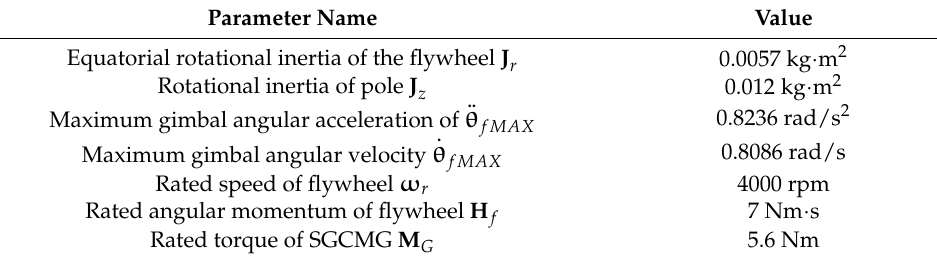
Figure 8. Experimental setup. ( a ) SGCMG prototype, ( b ) Octagonal cone−type SGCMGs. Table 4. Main parameters of SGCMG